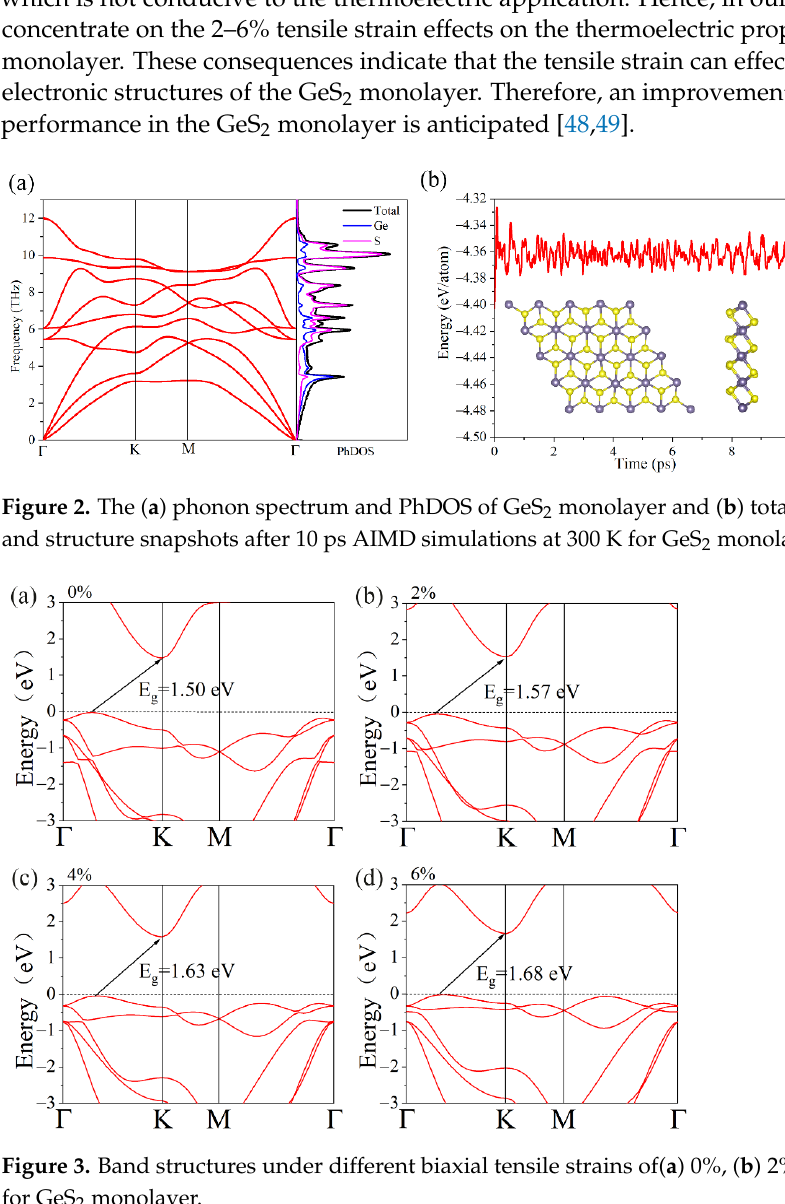
Figure 2. The ( a ) phonon spectrum and PhDOS of GeS 2 monolayer and ( b ) total energies evolution and structure snapshots after 10 ps AIMD simulations at 300 K for GeS 2 monolayer.